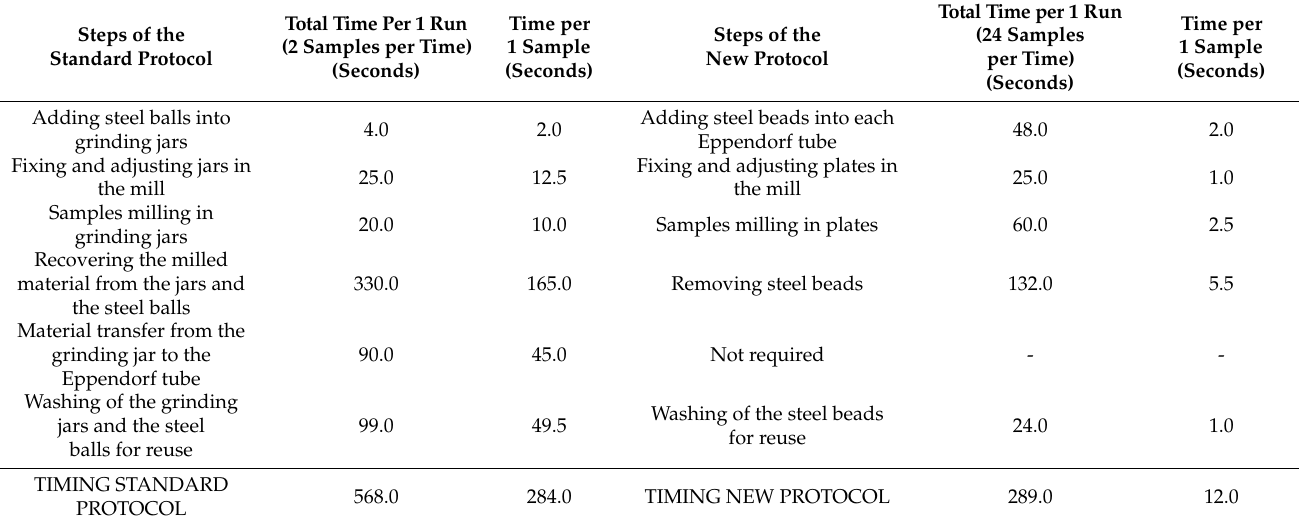
Timing comparison between the standard and the new protocol for milling one tree-ring